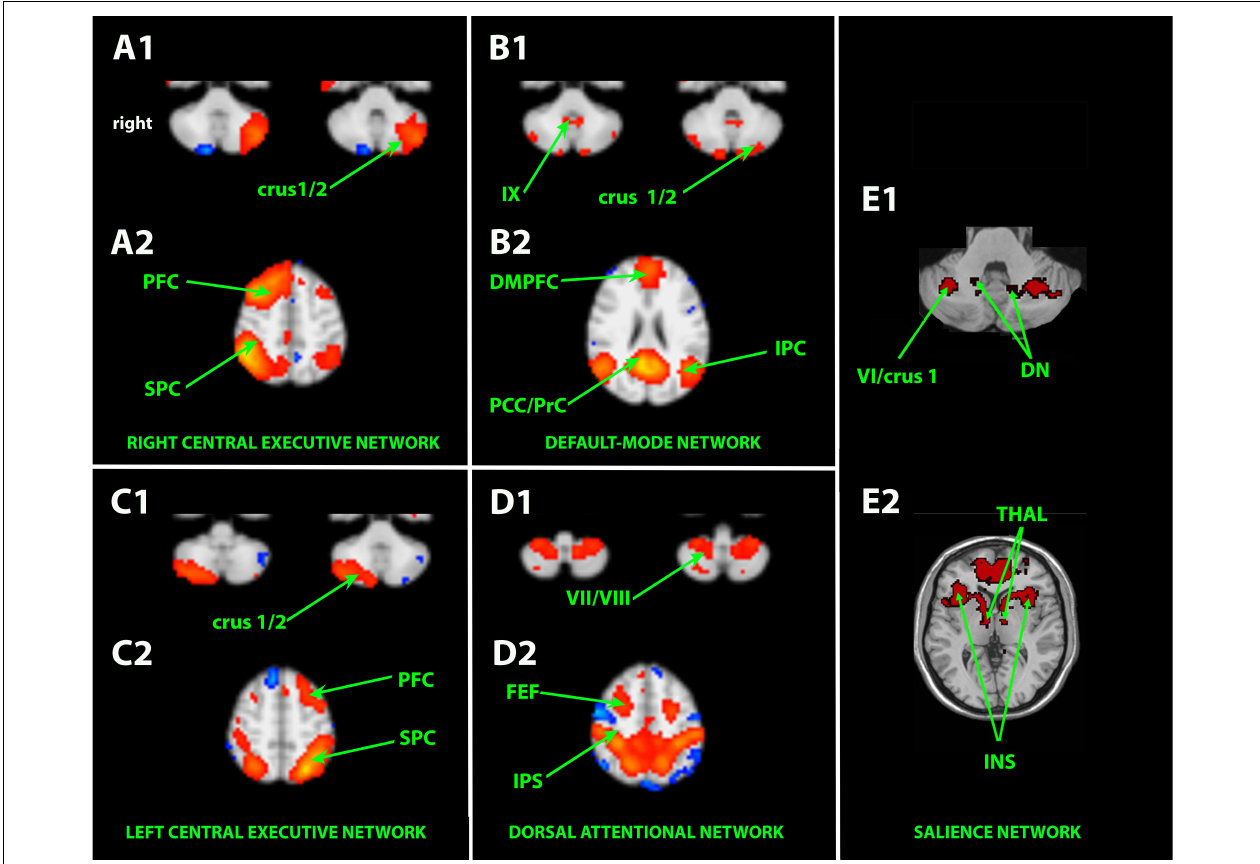
FIGURE 1 | Independent component analysis (ICA)-based resting-state associative cortico-cerebello-cortical networks. A1–B1–C1–D1–E1: axial slices passing through the neocerebellum. A2–B2–C2–D2–E2: axial slices passing through the brain. DMPFC, dorsomedial prefrontal cortex; DN, dentate nucleus; FEF, frontal eye field; INS, insula; IPC, inferior parietal cortex; PCC/PrC, posterior cingulate cortex/precuneus; PFC, prefrontal cortex; SPC, superior parietal cortex; Thal, thalamus. Cerebellar lobules are numbered with Latin numerals. Crus 1/2 corresponds to the hemisphere of lobule VIIA.